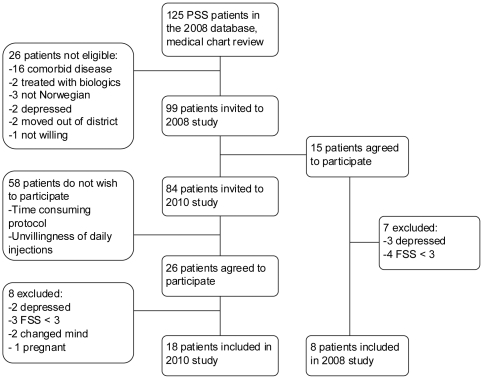
Flowchart of inclusion in the study.The pilot-study was conducted in 2008 and the main study in 2010. All patients underwent the same procedures. PSS, primary Sjögren's syndrome; FSS, Fatigue Severity Scale.